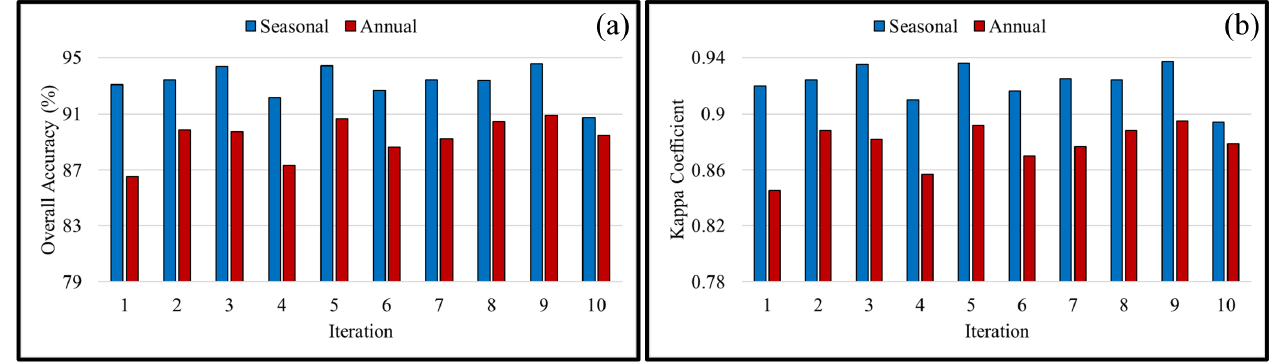
Figure 8. Overall accuracy (OA; ( a )) and Kappa coefficient (KC; ( b )) of annual and seasonal downscaling of SAR and optical data for mangrove ecosystem mapping.